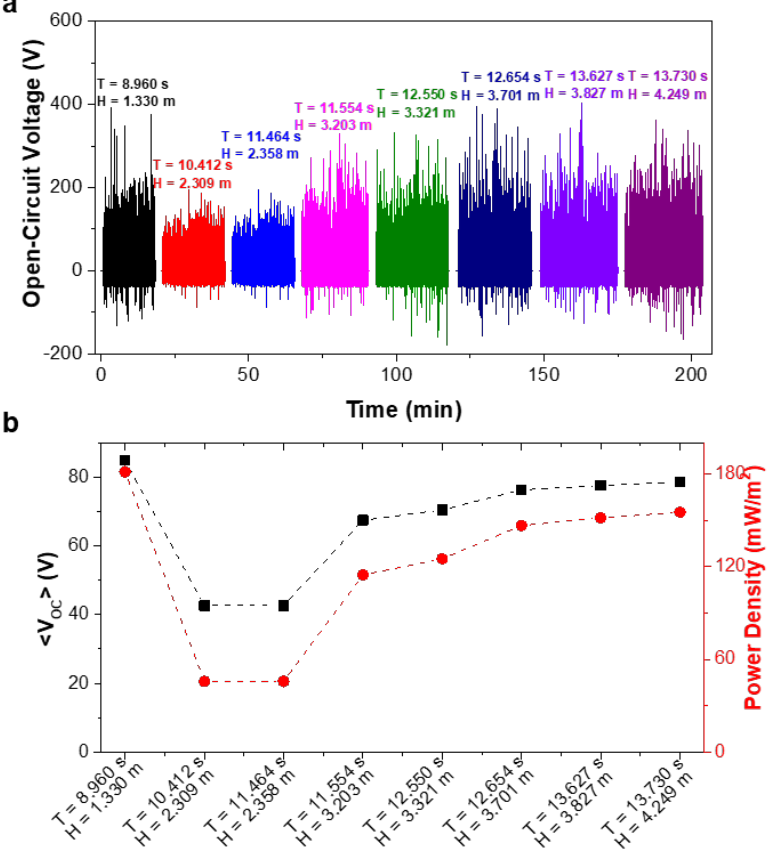
Figure 15. ( a ) Open-circuit voltage generated by lateral based TENG within the half-cylinder hull under studied sea states. ( b ) Mean voltage (dark line), power densities (red line) per meter square and kilogram generated by triboelectric device.